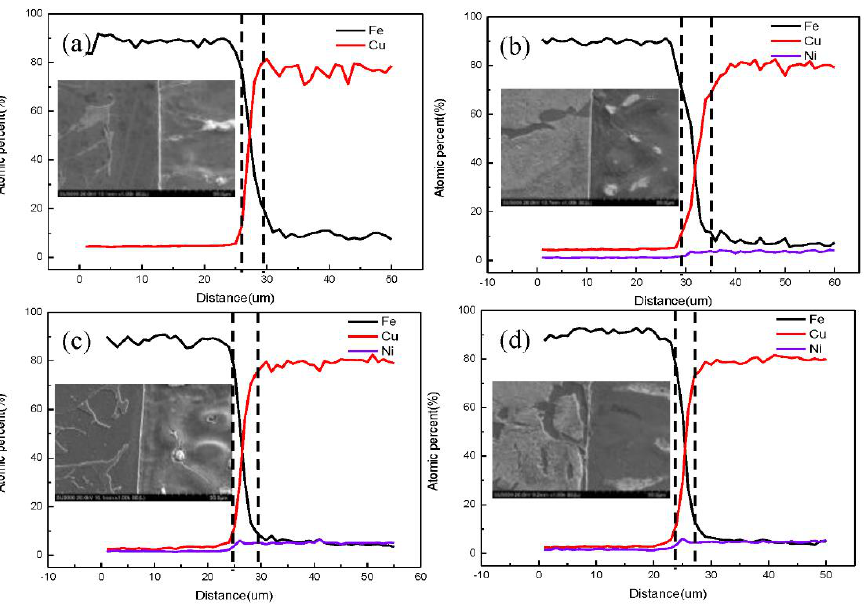
Figure 9. The microstructures and concentration profiles of Fe/Cu bimetallic specimens with: ( a ) 0% Ni; ( b ) 1% Ni; ( c ) 2% Ni; ( d ) 3% Ni.